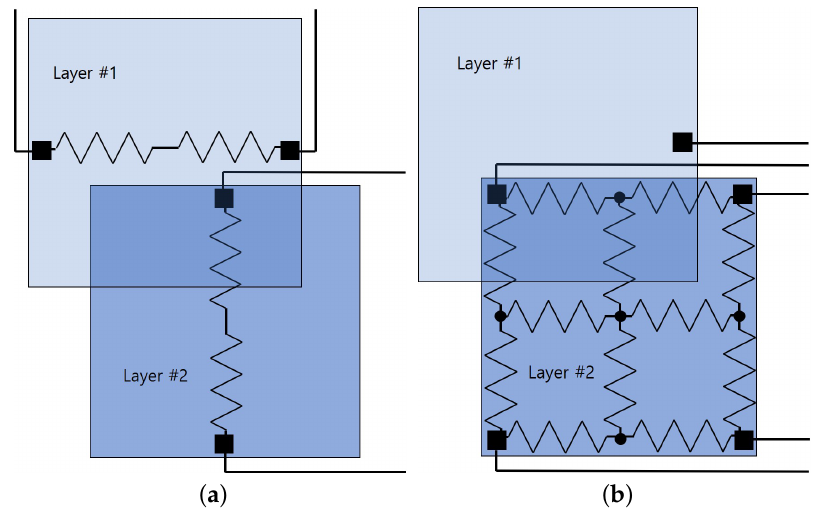
Figure 2. Two most popular resistive touchscreen architectures. ( a ) Four-wire. ( b )